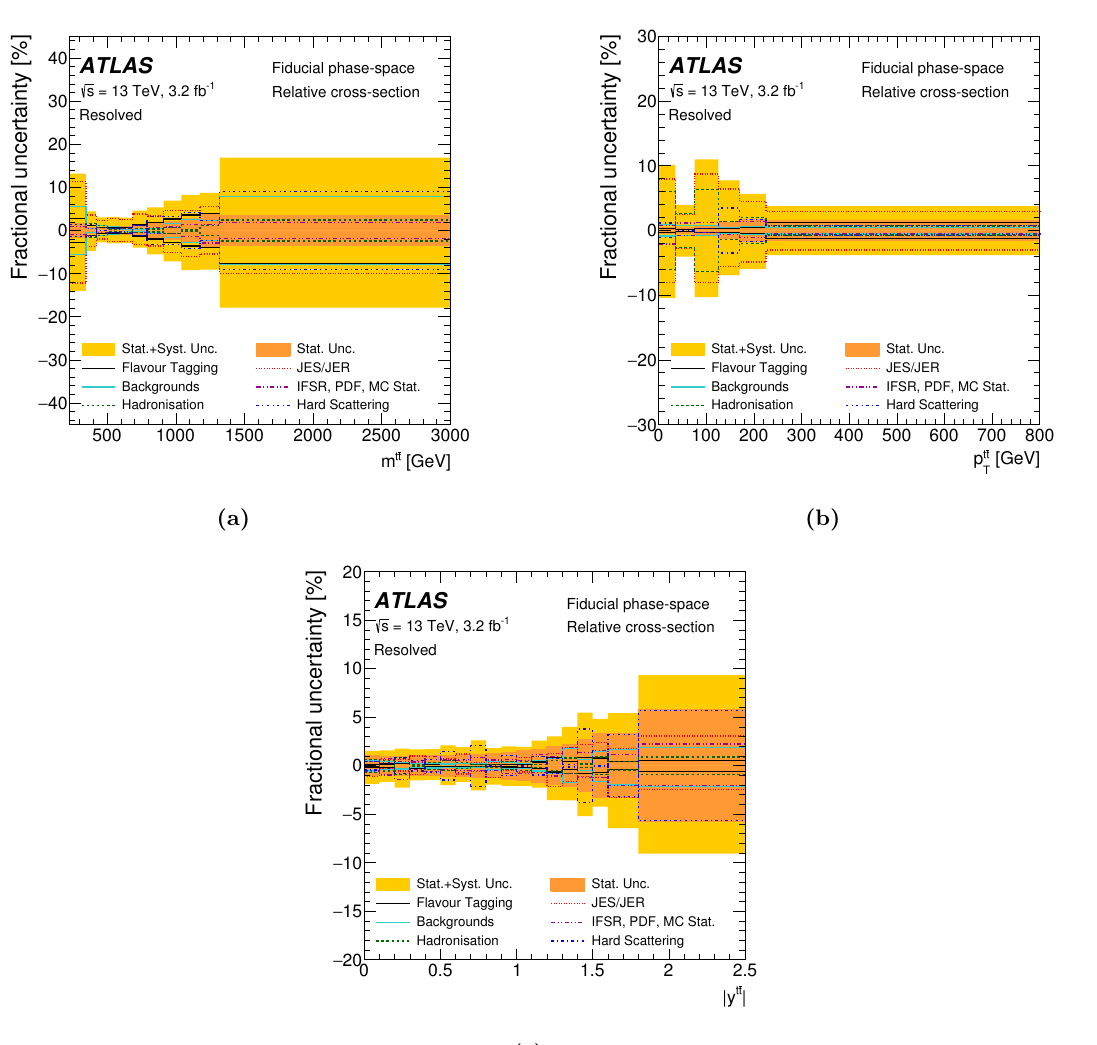
Figure 14. Uncertainties in the (cid:12)ducial phase-space relative di(cid:11)erential cross-sections as a function of the (a) invariant mass ( m t (cid:22) t ), (b) transverse momentum ( p t (cid:22) t (cid:12) (cid:22) t (cid:12) rapidity ( (cid:12) y t (cid:12) ) of the t (cid:22) t system in the resolved topology. The yellow bands indicate the total uncertainty of the data in each bin. The Powheg + Pythia6 generator with h damp = m t and the CT10 PDF is used as the nominal prediction to correct for detector